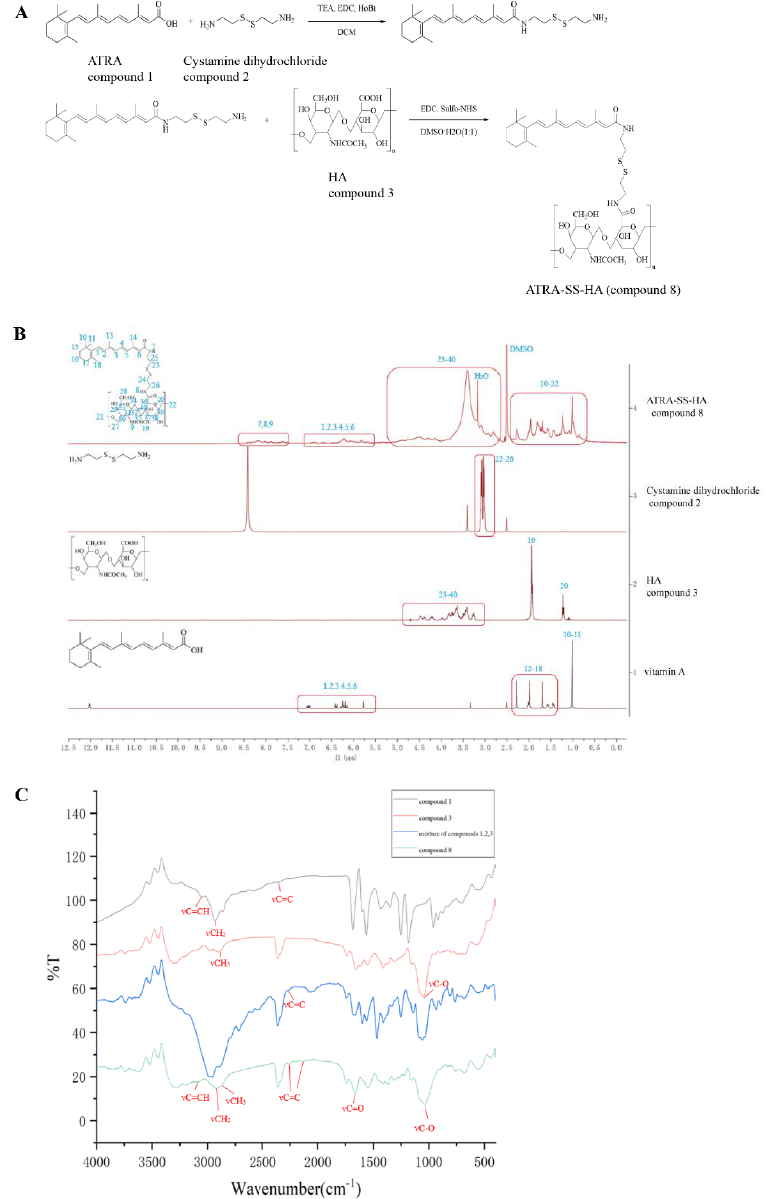
Figure 1. ( A )Synthesis of ATRA-SS-HA. ( B ) 1 H-NMR spectrum of ATRA-SS-HA (compound 8), unmodified HA (compound 3), vitamin A, and Cystamine dihydrochloride (compound 2). ( C ) FTIR of ATRA (compound 1), compound 3, mixture of compound 1,2,3 and compound 8.